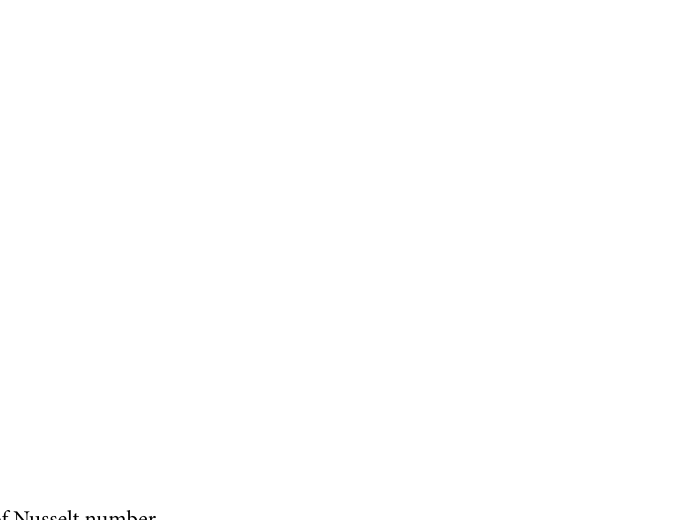
Table 2. The percentage variation of Nusselt